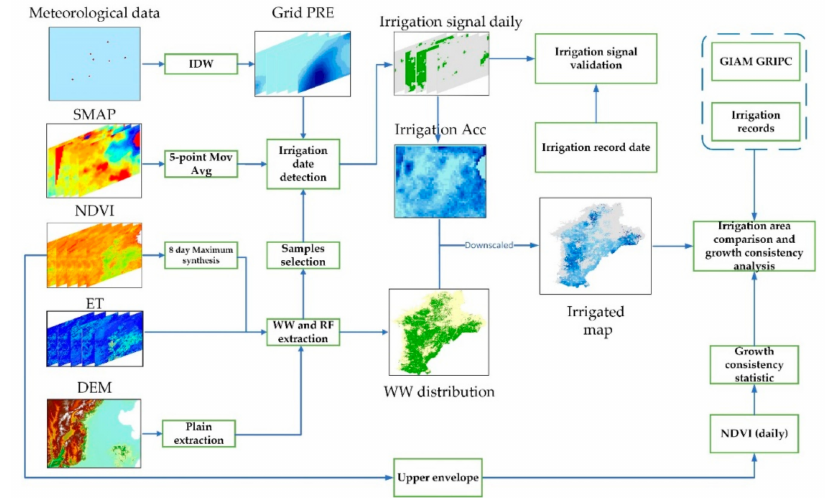
Figure 2. Flow chart for this study. Here, 5-point Mov Avg represents the 5-point moving average and Avg and Std represent the average and standard deviation, respectively. The irrigation Acc accumulates as a result of the irrigation